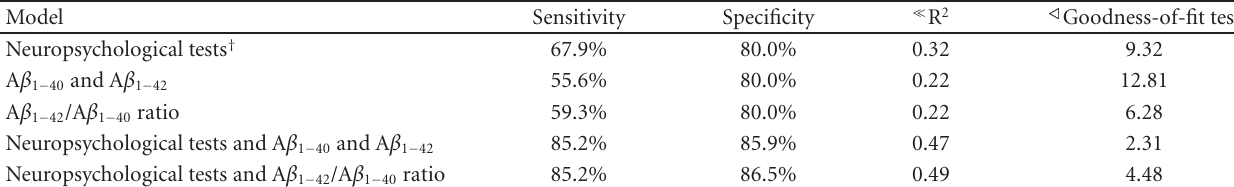
Table 2: Optimal sensitivities with specificities at least 80% for the various models ∗